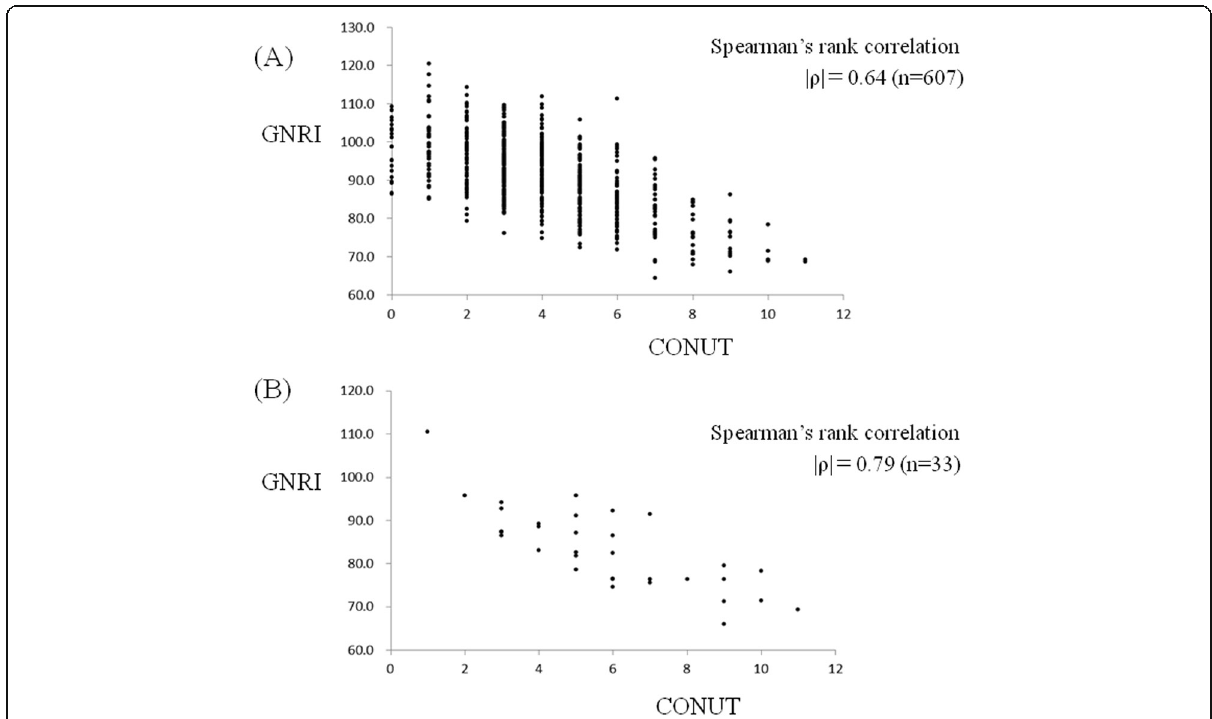
Fig. 3 The correlation analyzed Spearman ’ s rank correlation test between the GNRI and the CONUT is shown. The ρ value was 0.64 in the total of 607 patient series ( a ) and that was 0.79 in the 33 non-survivor group ( b